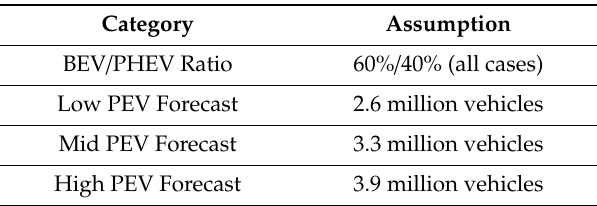
Table 8. PEV Fleet Input Assumptions for 2030.